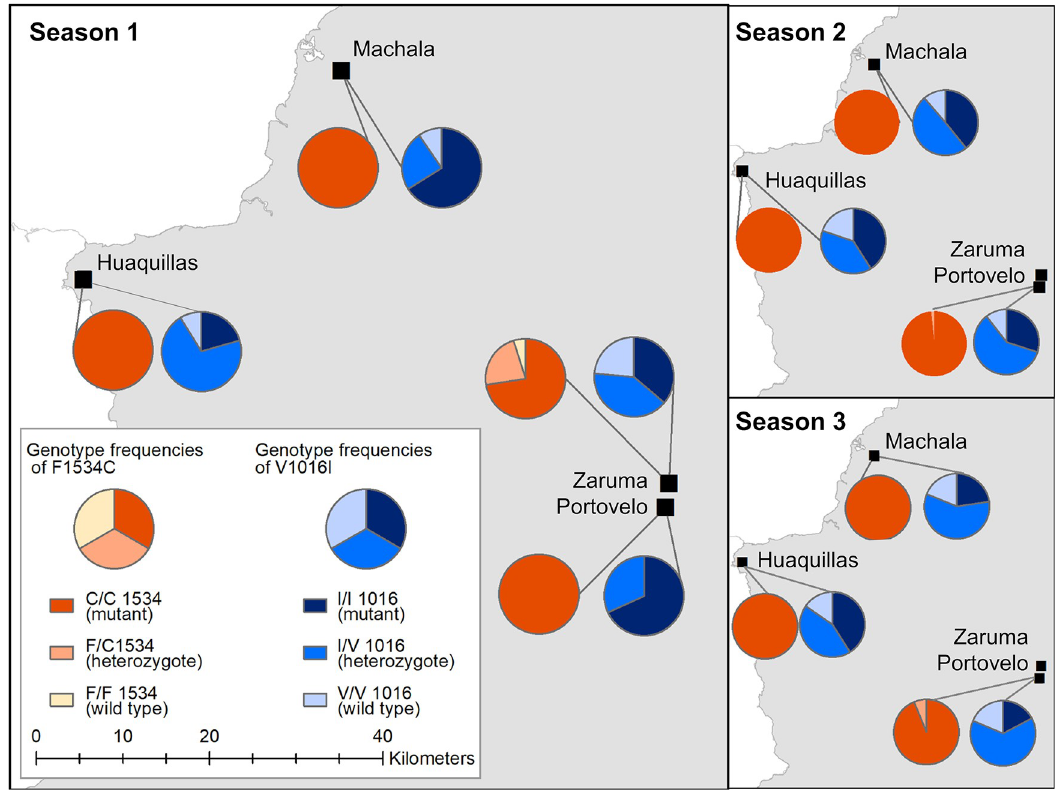
Fig 3. Genotypic frequencies of the V1016C and F1534C alleles at the four study cities during Seasons 1, 2, and